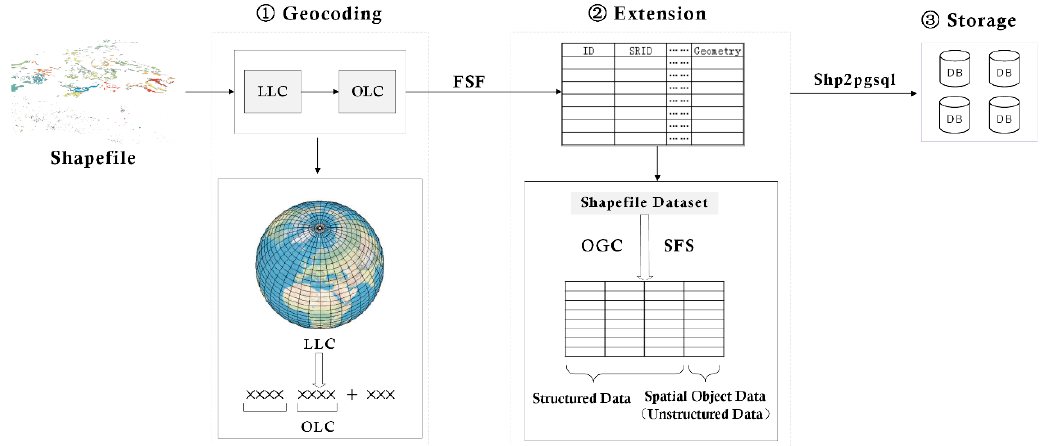
Figure 3. Architecture of the proposed SSPOG method.